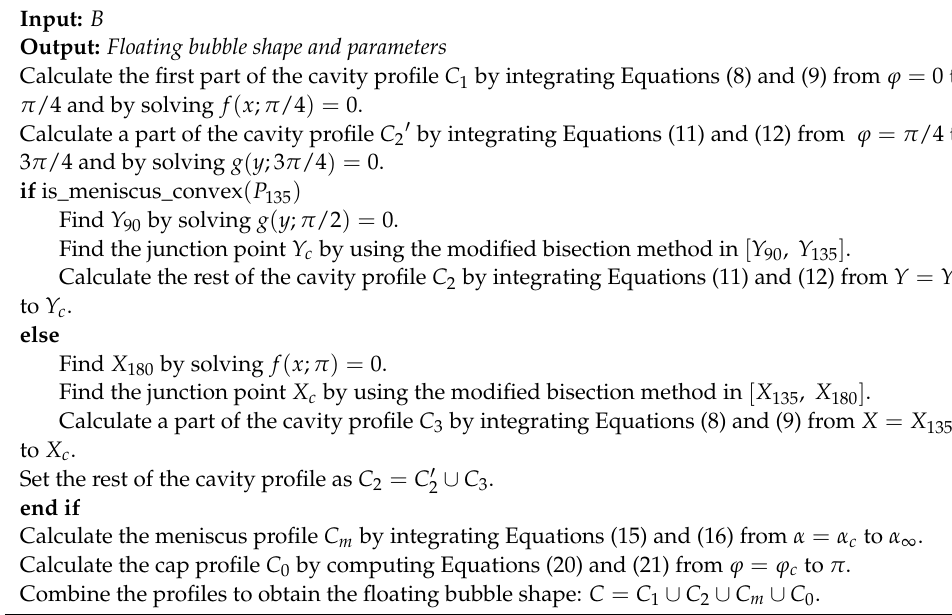
Algorithm 2 The improved numerical procedure for calculating the shape of a floating